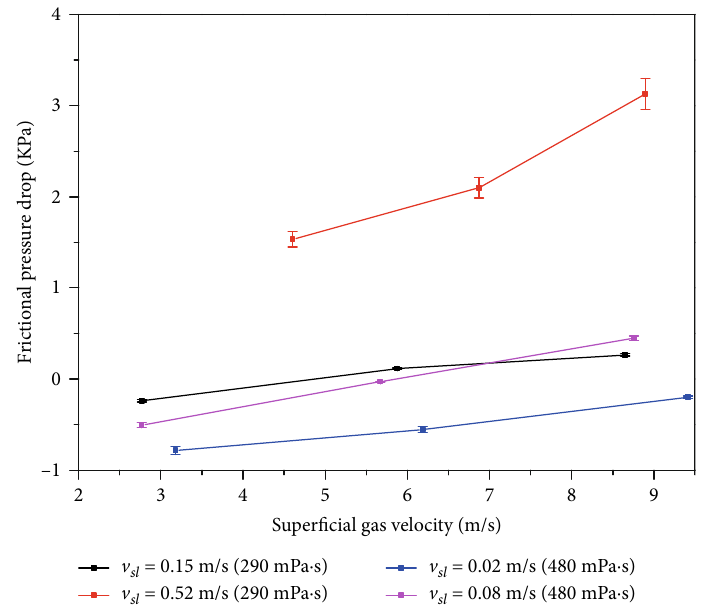
Figure 4: Frictional pressure drop vs. super fi cial gas